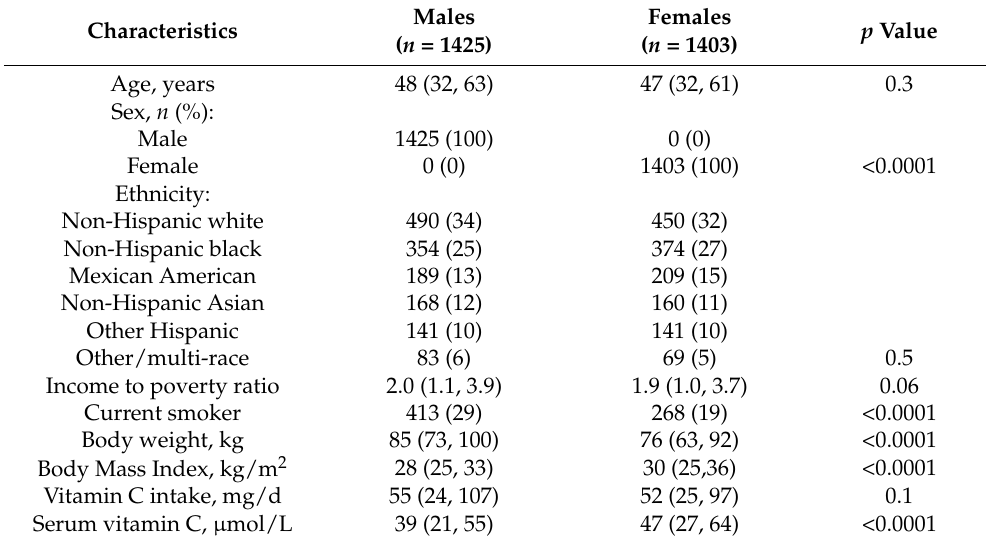
Table 2. Cohort characteristics stratified by